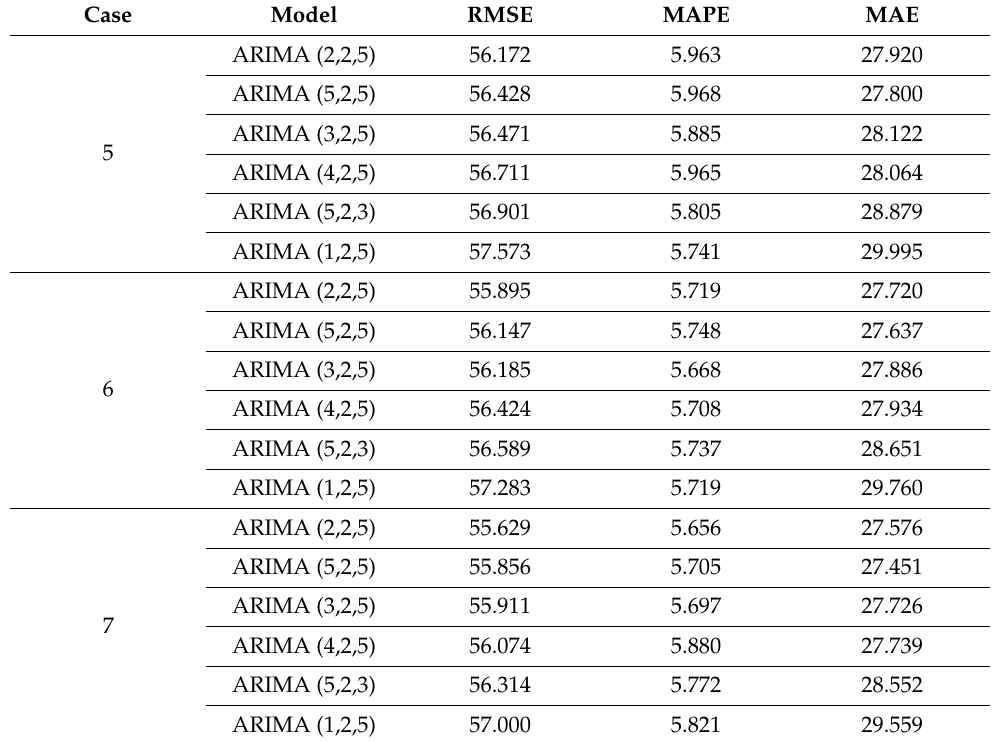
Table 4. Results of ARIMA models for Group 2 (case 5–7).